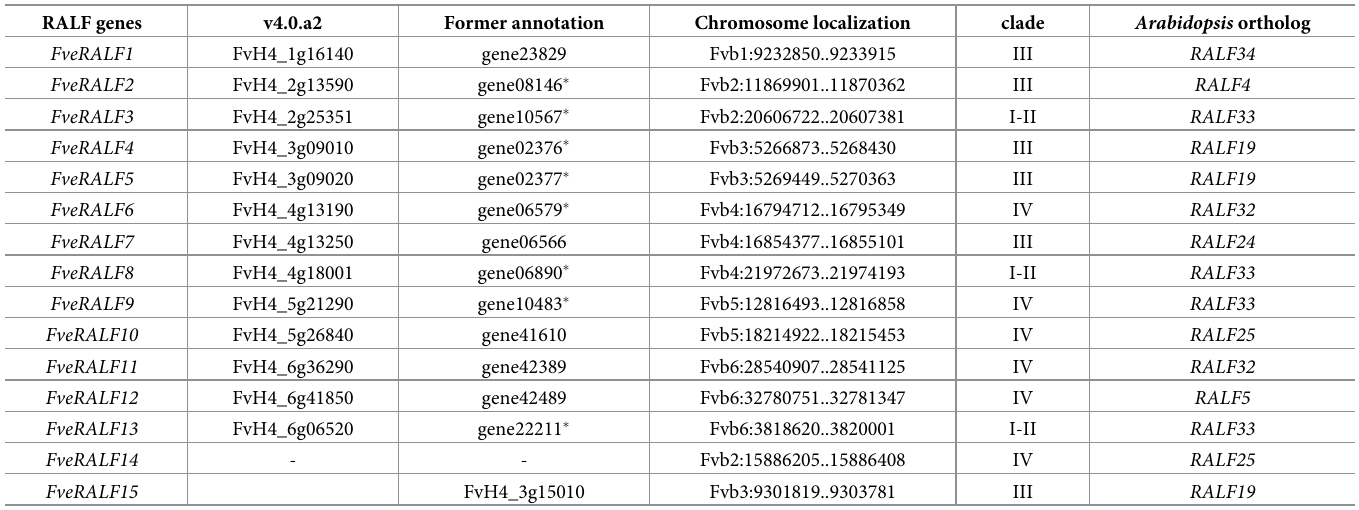
Table 1. List of RALF genes identified in F . vesca